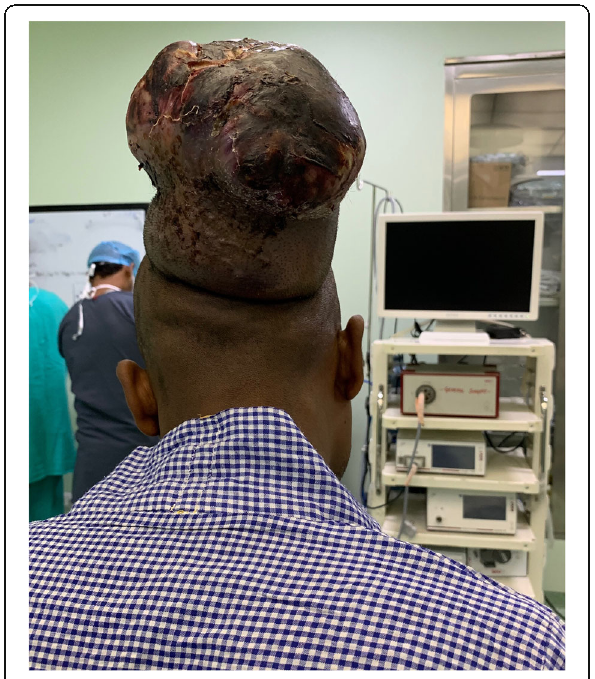
Fig. 1 Patient with giant occipital tumor almost equal to the size of his